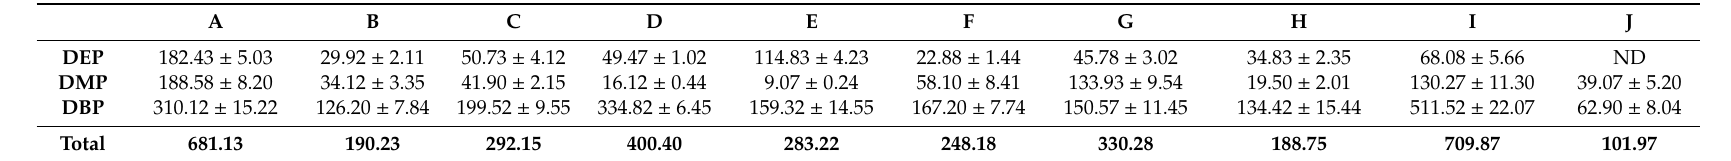
Table 2. Concentrations ( µ g / kg) of PAEs in PET